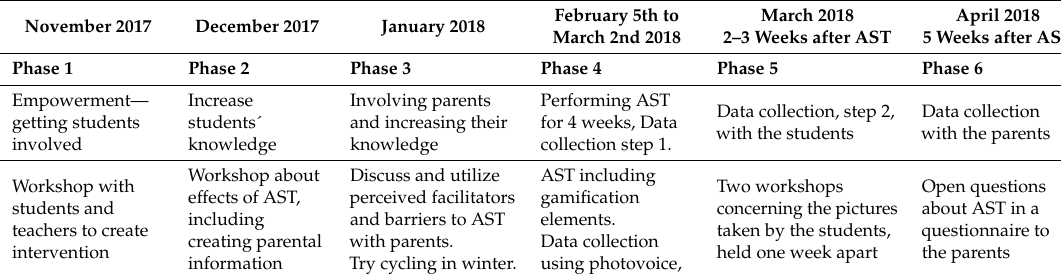
Table 2. Overview of the timeline of the